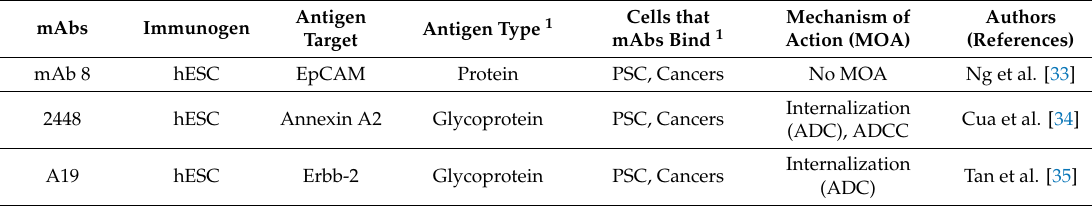
Table 2. Summary of mAbs generated against PSCs and used in